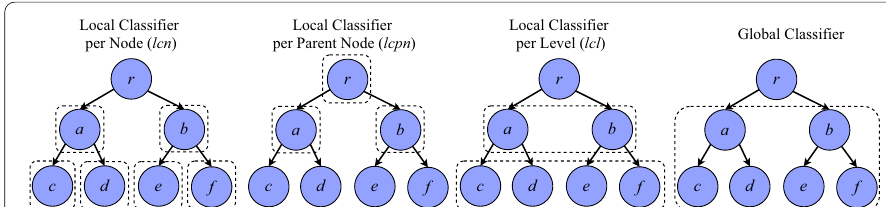
Fig. 1 Example of global and local methods for hierarchical multi-label classification. Given a hierarchy of classes ( r , a , b , c , d , e , and f ), the dashed boxes show the number of classifiers required for each method. Note that the lcn , lcpn , lcl , and global classifiers require 6, 4, 3, and 1 predictors,